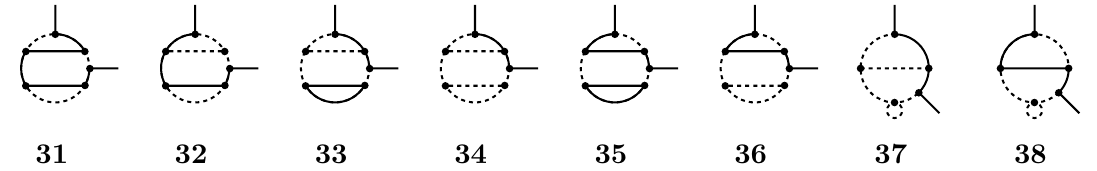
Figure 4 . List of new special genuine diagrams in the mass basis, i.e. with the external Higgs lines removed. The numbering follows that of (cid:12)gure 8 of the paper and should be understood as a continuation of that (cid:12)gure.